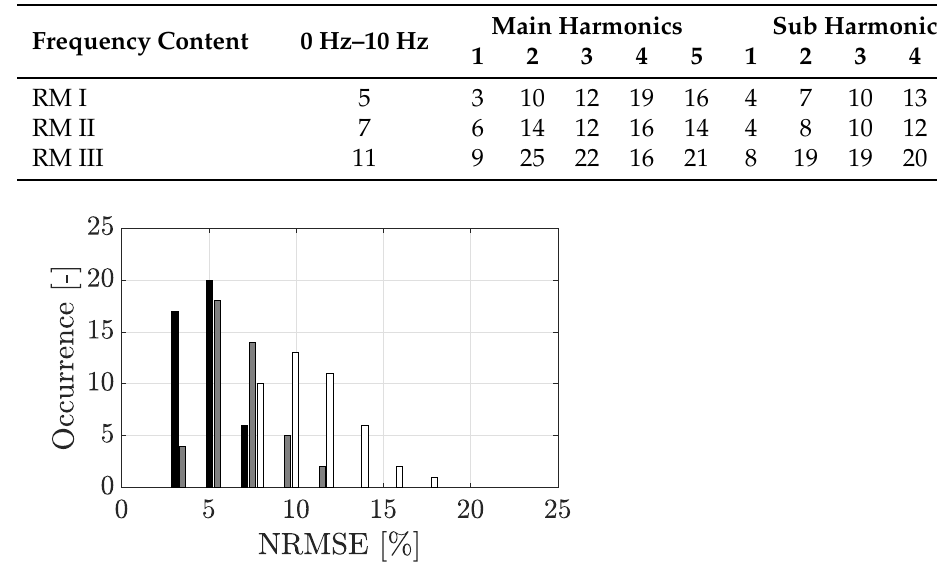
Table 3. Summary of the NRMSE [%] of the reconstructed contact force using the different recon- struction methods with respect to the measured contact force.